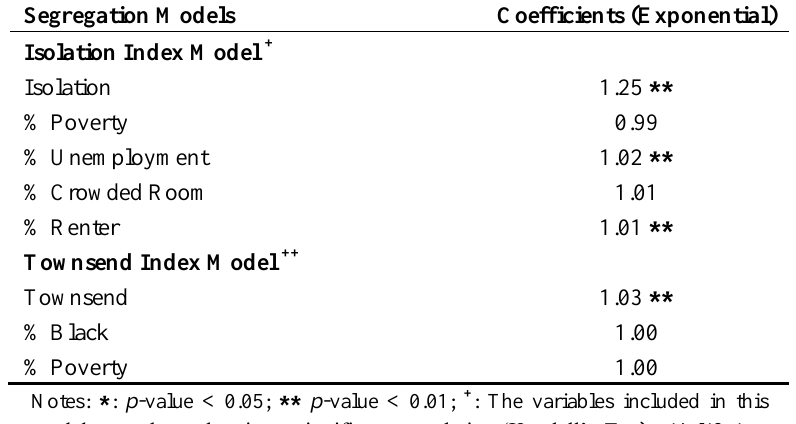
Table 3. Poisson multivariate regression of lifetime cancer risk from air toxics by isolation index and Townsend